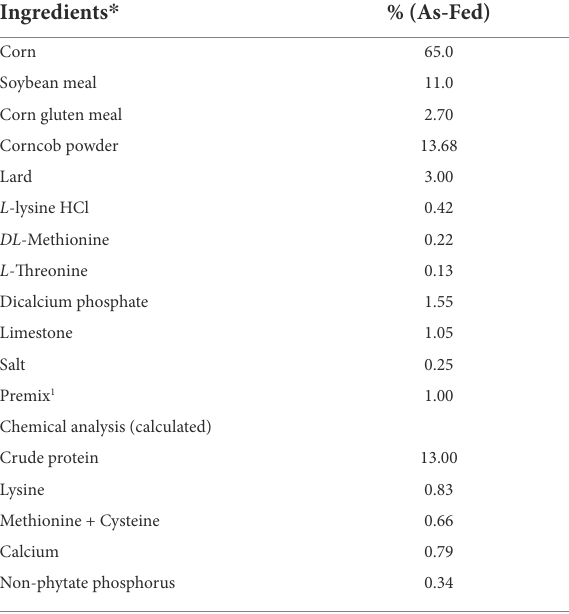
TABLE 1 Composition and nutrient levels of experimental diet (% as